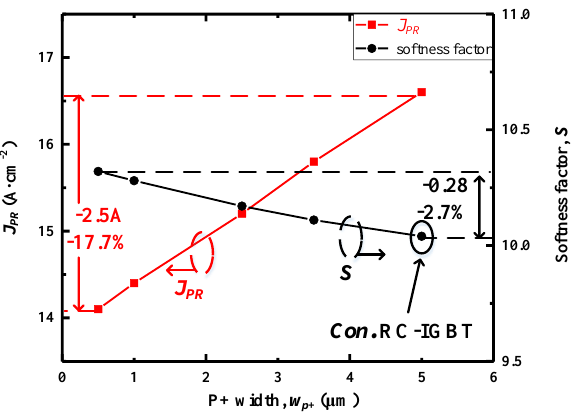
Figure 7. The change in the J PR and softness factor S with different P+ emitter widths.